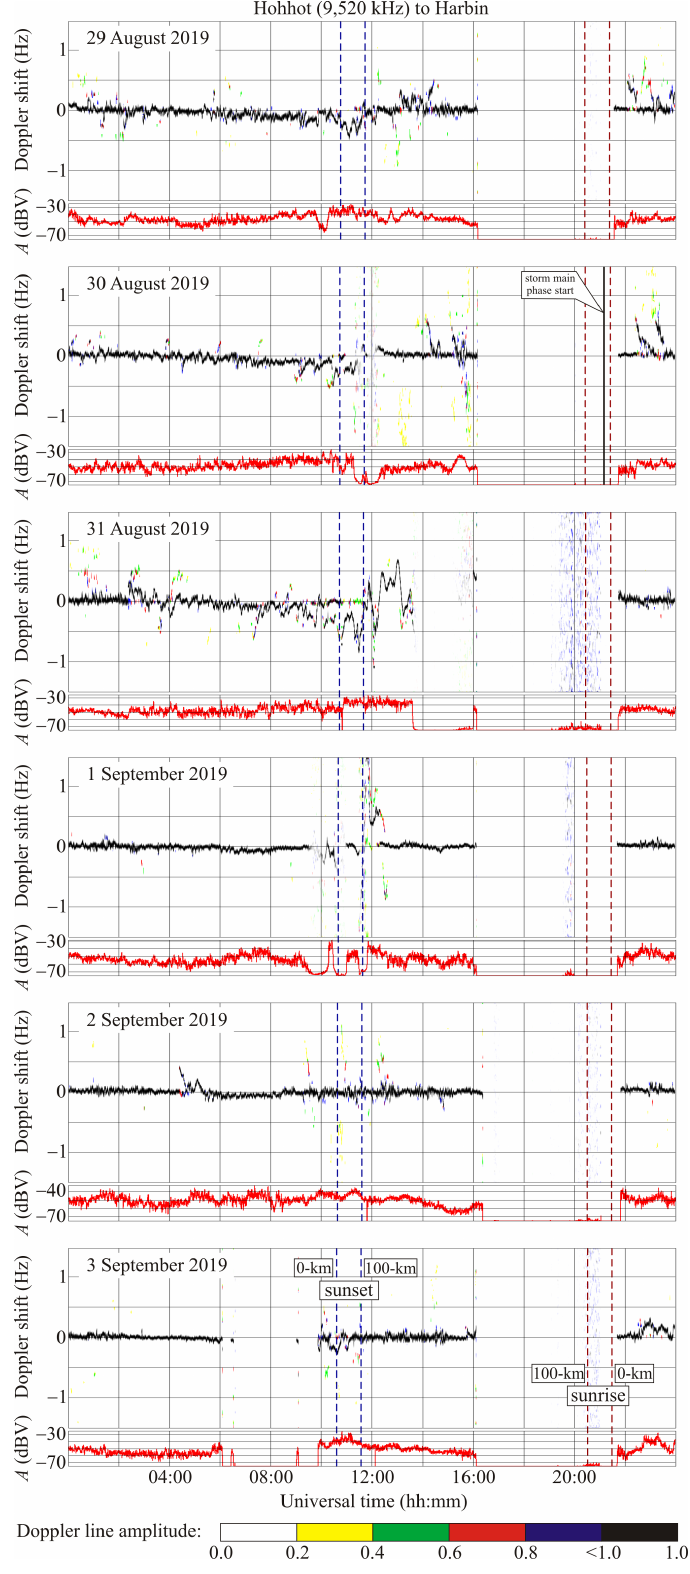
Figure 13. Same as Fig. 5 but for the Hohhot to Harbin radio wave propagation path at 9520kHz.